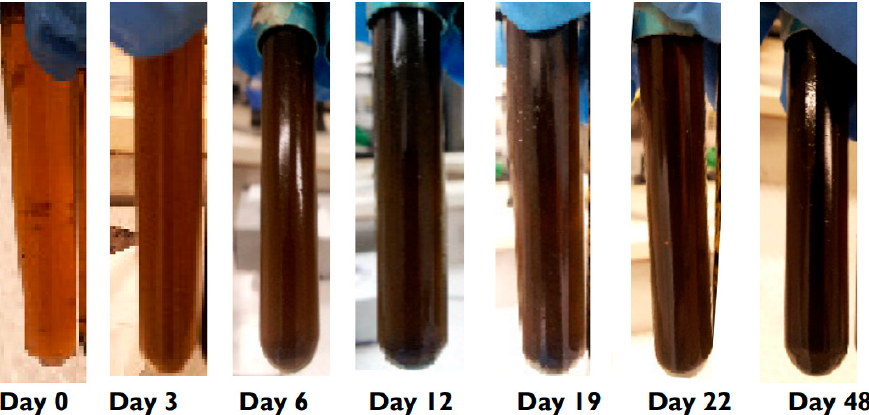
Figure 1. Growth of the IRB, Shewanella putrefaciens in B7 medium.